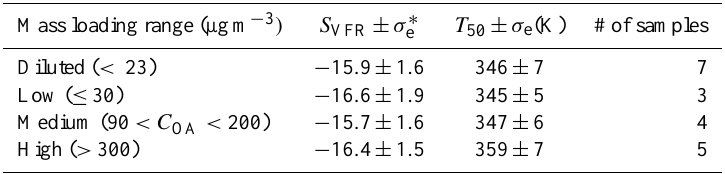
Figure 2. Mass thermograms measured for each of the experiments (symbols). Results are grouped according to the bypass mass loading as (a) high ( C OA > 300µgm − 3 ) , (b) medium (90 ≤ C OA < 300µgm − 3 ) , and (c) low loading ( C OA ≤ 30µgm − 3 ) . Results from isothermal dilution experiments are shown in (d) , where the initial number is the C OA before dilution and the number in parentheses is that after dilution. Traces represent the fit of Eq. (2) to each experiment. Table 2. The average fit parameters for each C OA grouping of mass